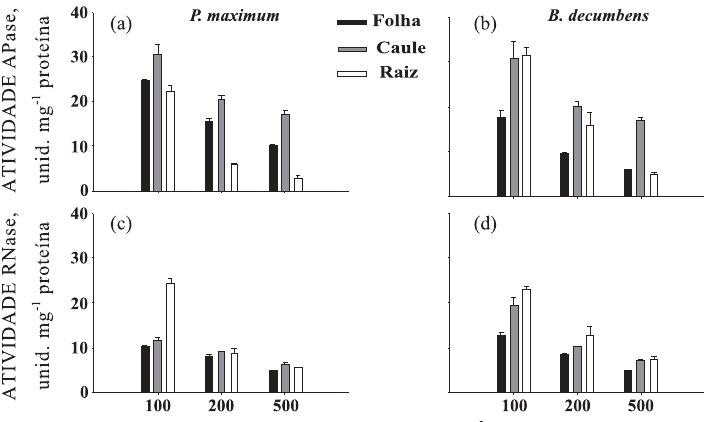
Figura 1. Atividade de fosfatase ácida – APase (a, b) e ribonuclease - RNase – (c, d) na folha, caule e raiz de plantas de Panicum maximum (a, c) e Brachiaria decumbens (b, d) coletadas aos 60 dias após o transplantio, antes do início dos tratamentos com cortes, de acordo com as doses de 100, 200 e 500 mg dm -3 de P. As linhas sobre as barras correspondem ao